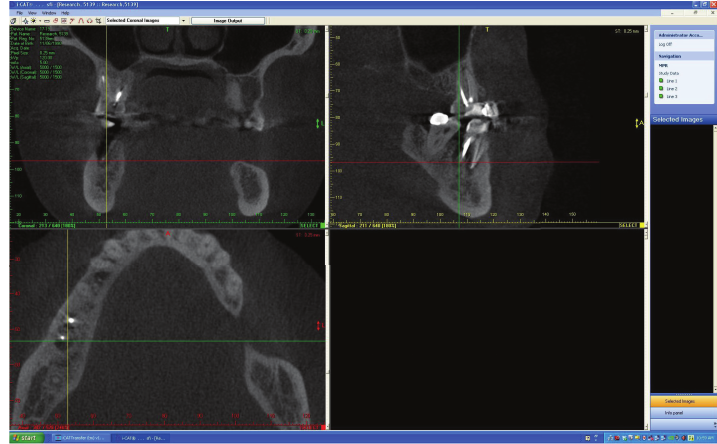
Figure 2: Cone Beam CT image of molar tooth as viewed by observers in the study.